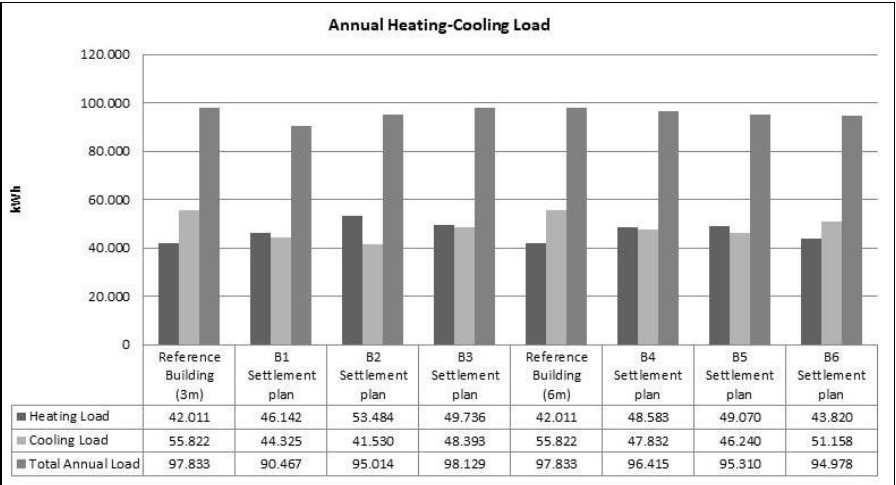
Figure 7. The effect of change of courtyard form on heating-cooling load values. Figure 7. The e ff ect of change of courtyard form on heating-cooling load